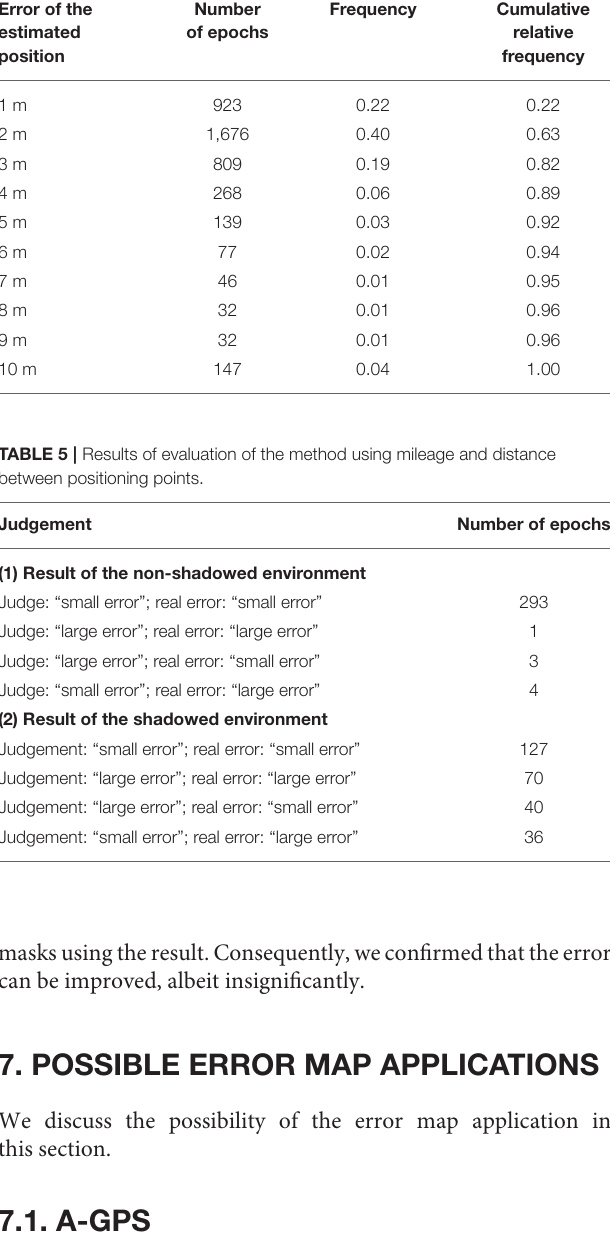
TABLE 4 | Detailed result of frequency of error (front). Error of the estimated